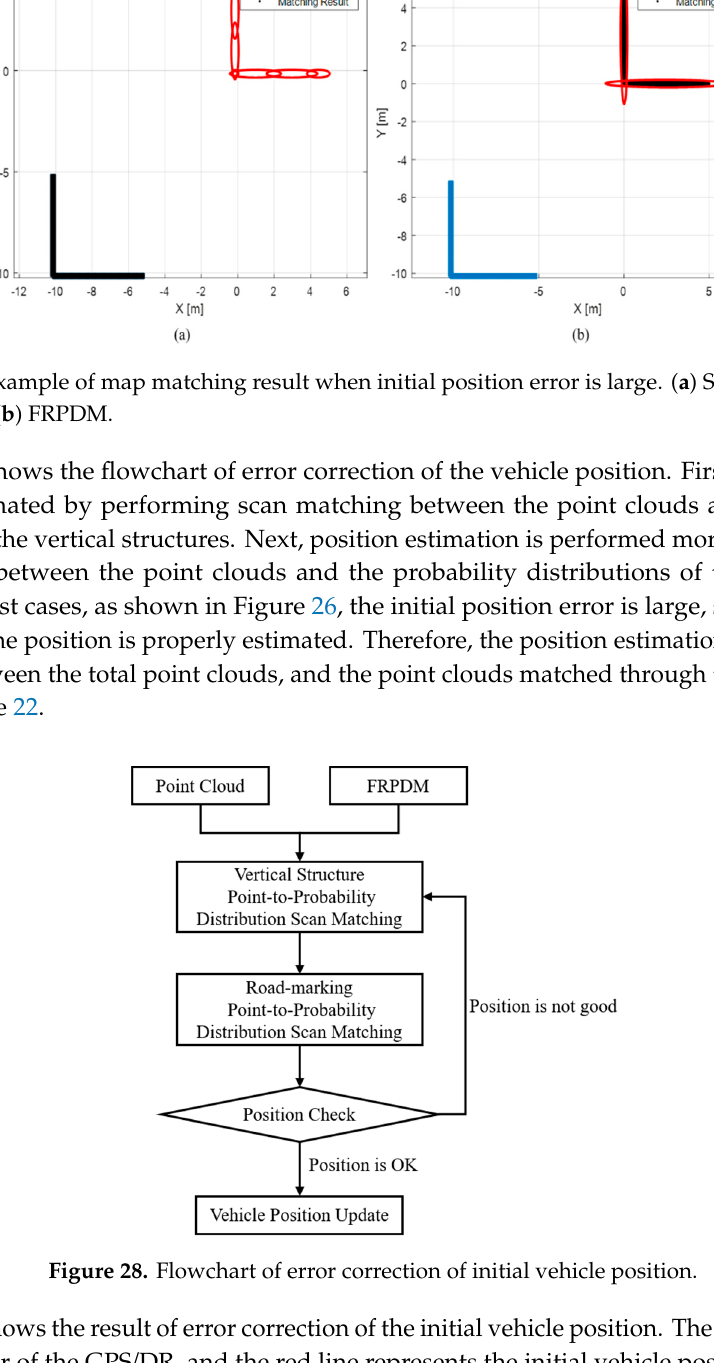
Figure 29. Result of error correction of initial vehicle position.